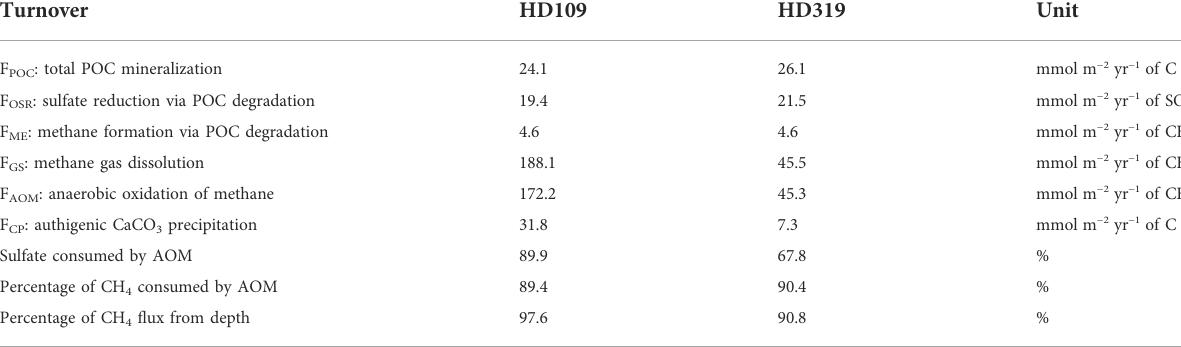
TABLE 7 Depth-integrated turnover rates according to the steady-state